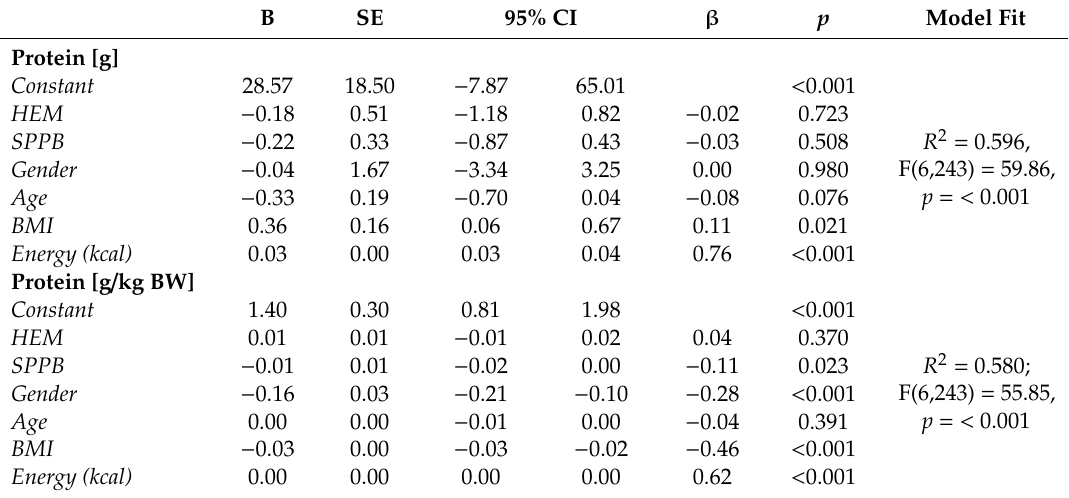
Table 3. Results of the final step of the hierarchical multiple regression analysis (Model 4) testing the association of HEM and total protein intake ( N = 250).